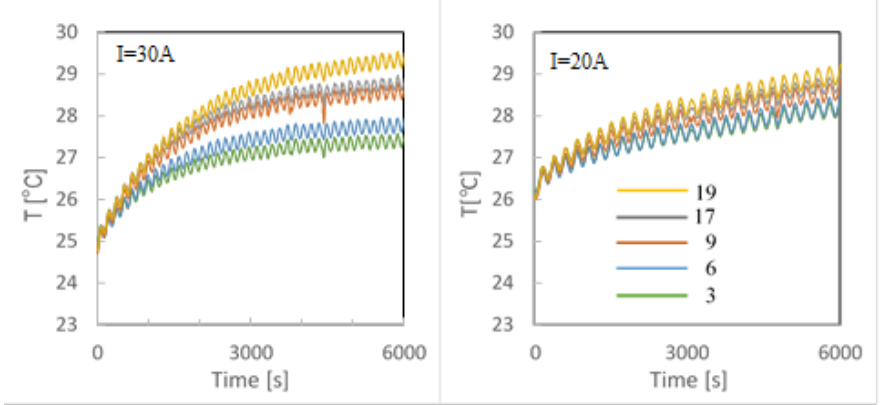
Figure 11. Evolution of T3, T6, T9, T17, and T19 as a function of time.